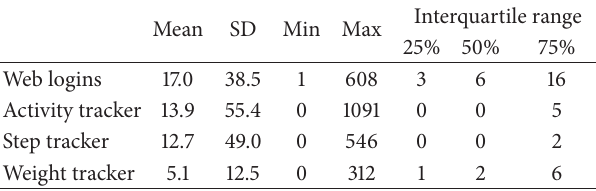
Table 1: Summary of website